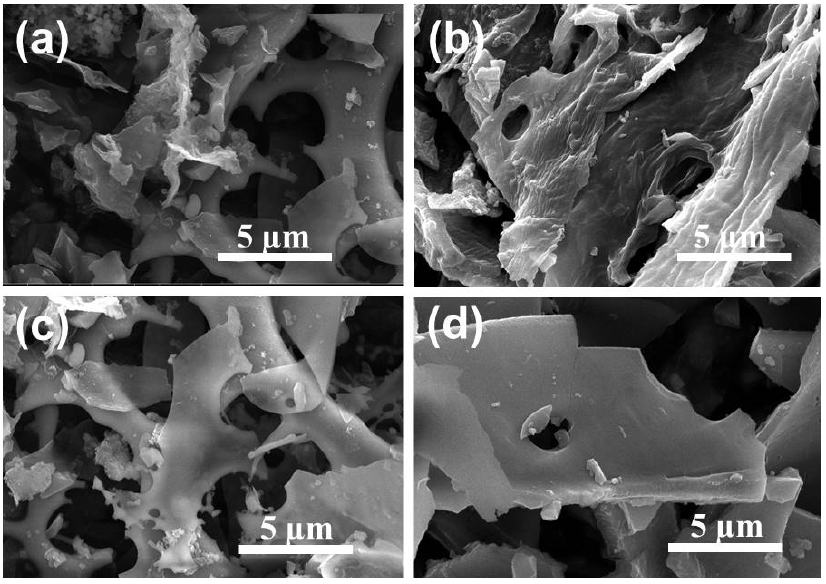
Figure 3. SEM images of ( a ) MHPC-700, ( b ) MHPC-800, ( c ) MHPC-900, and ( d ) NHPC-700.